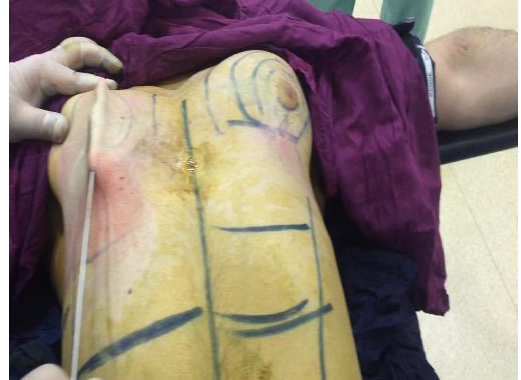
Figure (1)Lliposuction of the breas